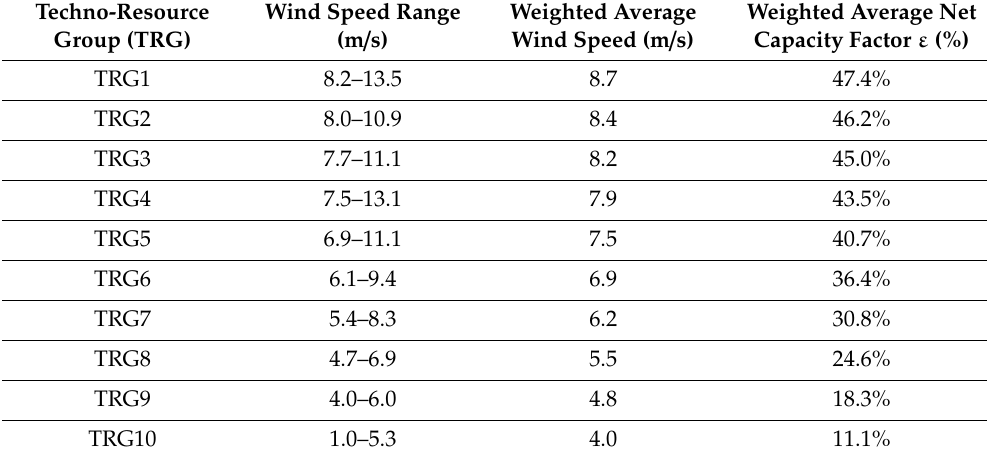
Table 1. Techno-resource group (TRG) definitions for land-based wind. Data in the table reproduced from [15]. Credit the U.S. Department of Energy (DOE) / NREL / ALLIANCE. Copyright